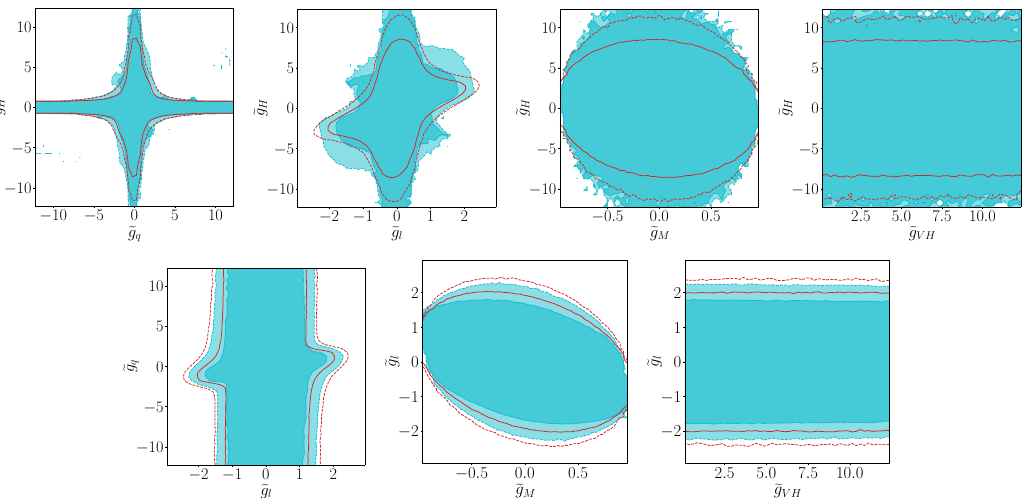
Figure 13: 5-parameter fit to the full data set for the model parameters in Eq.(10) for = 8TeV. Each panel shows profiled ∆ χ 2 = 2.3 (solid) and ∆ χ 2 = 5.991 fixed m V (dashed) contours. Red curves correspond to tree-level matching, the light blue re- gion to 1-loop matching, profiled over three ˜ g parameters plus the matching scale − ˜ g − ˜ g − ˜ g Q = 500GeV ... m ˜ g . The panels for ˜ g and ˜ g are not shown V M q VH q VH M as they are unconstrained in the explored